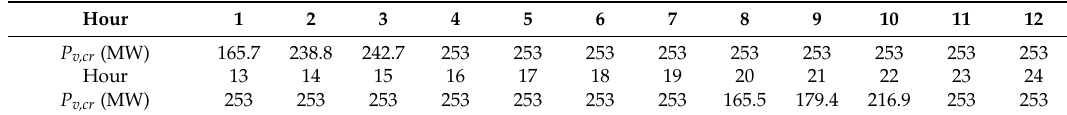
Table 5. The critical value of WPP output power.